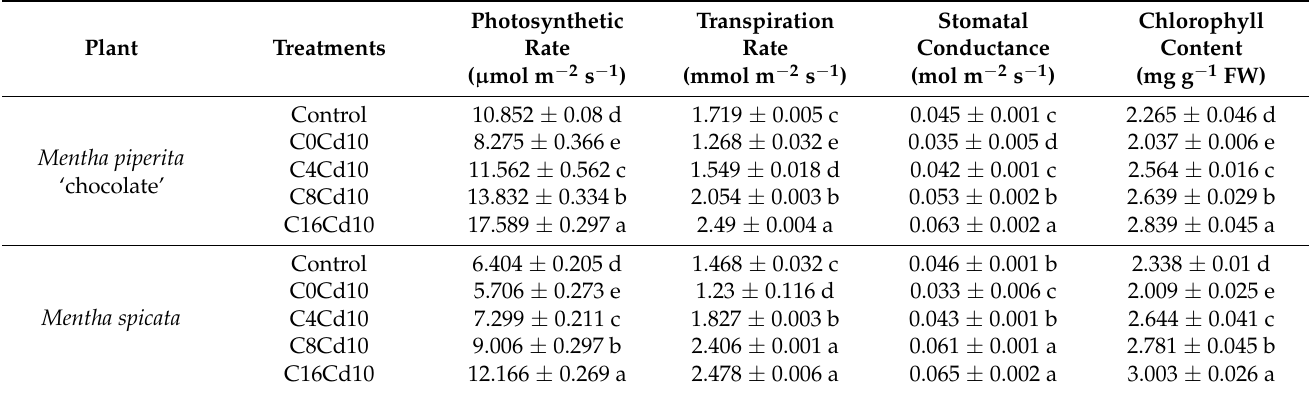
Table 4. Effect of biochar on gas exchange parameters and chlorophyll content of two mint species under Cd